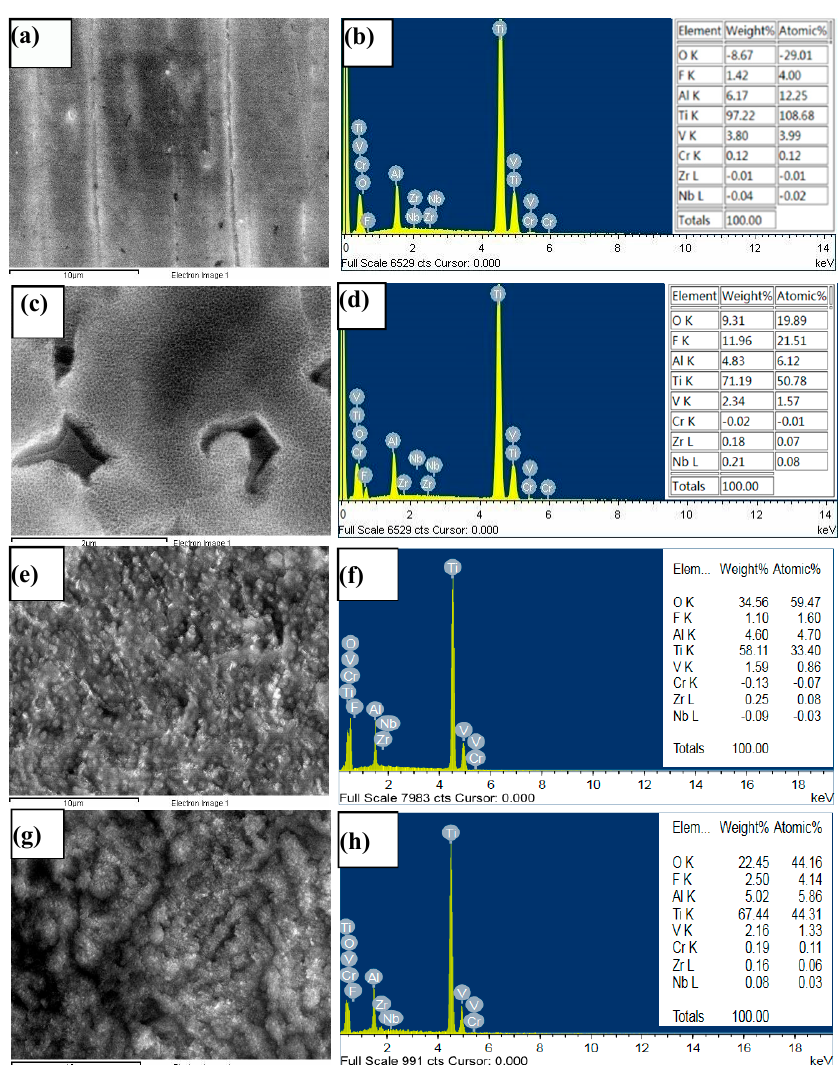
Figure 6. Energy-dispersive X-ray spectroscopy (EDS) elemental analysis of TiO 2 nanotube thin film: ( a , b ) substrate; ( c , d ) anodized sample annealed at 600 °C ( e , f ) in air atmosphere and ( g , h ) in Ar atmosphere.